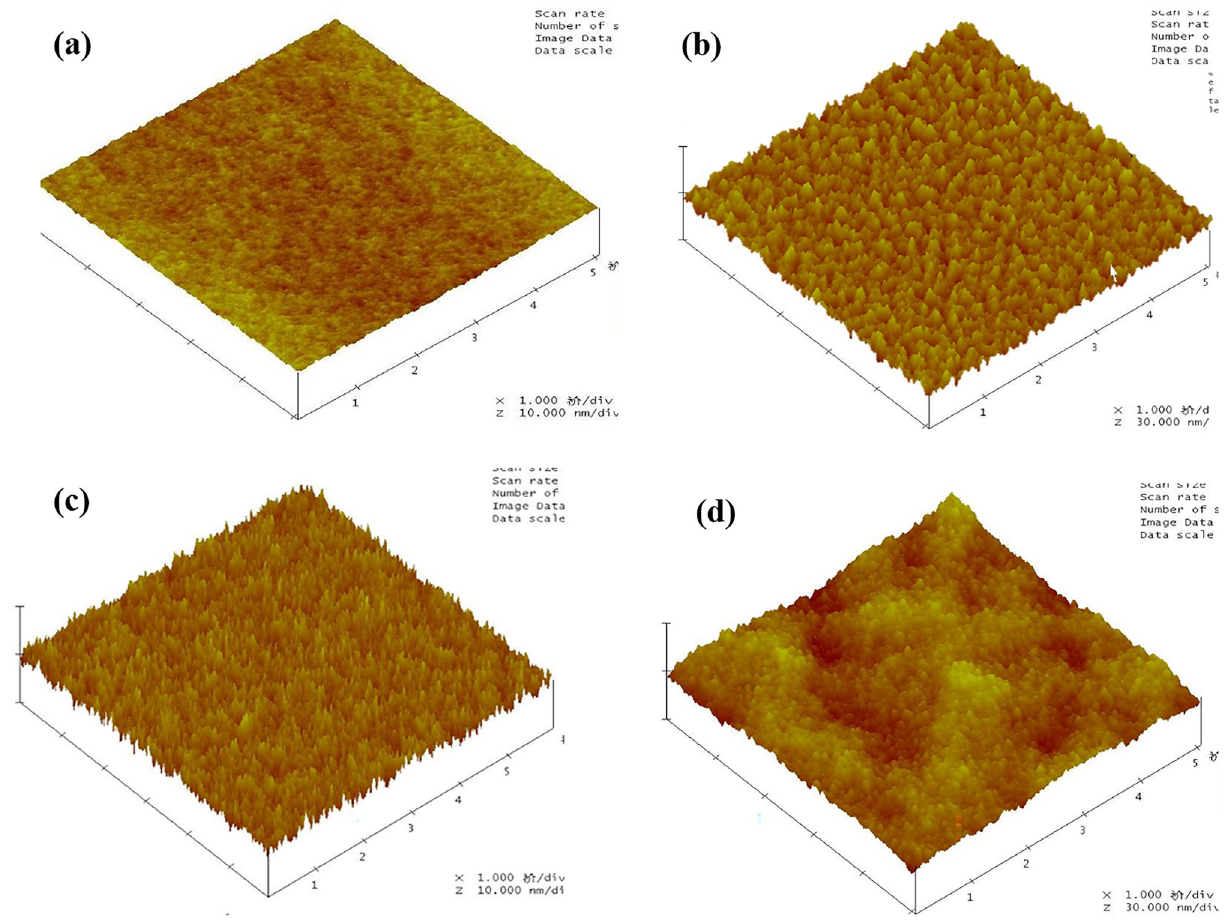
Figure 4. AFM image of NbN film on 4 μm PI with Si substrate: ( a ) without NbN film ( b ) 8 nm NbN film ( c ) 50 nm NbN film ( d ) 200 nm NbN